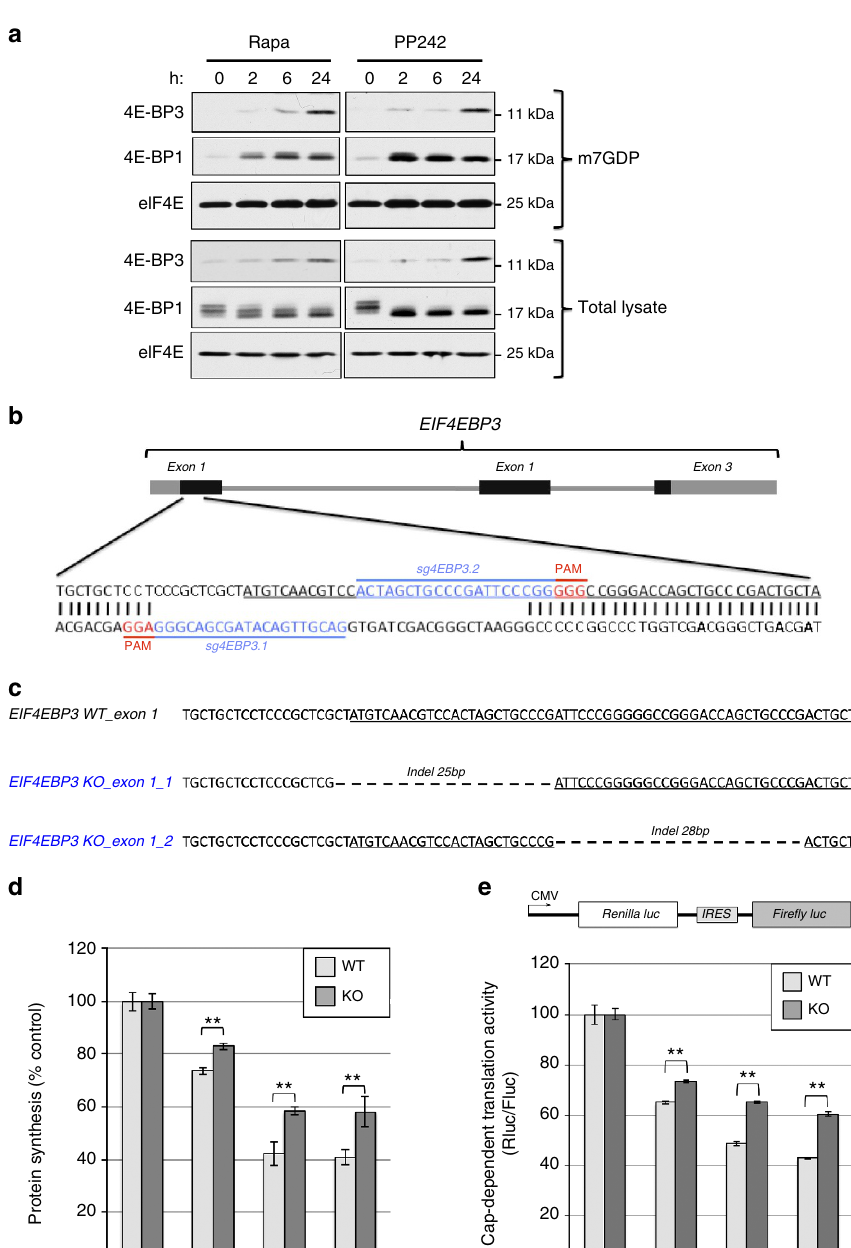
Figure 4 | 4E-BP3 limits cap-dependent translation during mTORC1 inhibition. ( a ) MiaPaCa-2 cells were treated with mTOR inhibitors (Rapa 100nM and PP242 1 m M) for the indicated time. Lysates were subjected to m 7 GDP pull-down assay. A representative result of two independent experiments is shown. ( b ) Exon 1 of human EIF4EBP3 targeted by the Crispr-Cas9 nickase system. Targeted sequences are shown in blue. Protospacer adjacent motif (PAM) is highlighted in red. Protein coding region is underlined. ( c ) Internal deletion induced by two sgRNAs targeting EIF4EBP3 . Protein coding region is underlined. ( d ) Protein synthesis was measured by a non-radioactive puromycin labelling (SUnSET) assay (see the method). ** P o 0.01. Statistical significance was determined using two-way analysis of variance (ANOVA). A representative result of three independent experiments is shown. ( e ) A diagram of the bicistronic reporter construct (top). MiaPaCa-2 cells were transfected with the bicistronic reporter plasmid construct for 24h and then treated with mTOR inhibitors for 12h. Each luciferase activity was measured using Dual-Luciferase Assay kit (Promega). Error bars indicate ± s.d. ( n ¼ 3). ** P o 0.01. Statistical significance was determined using two-way ANOVA. A representative result of three independent experiments is